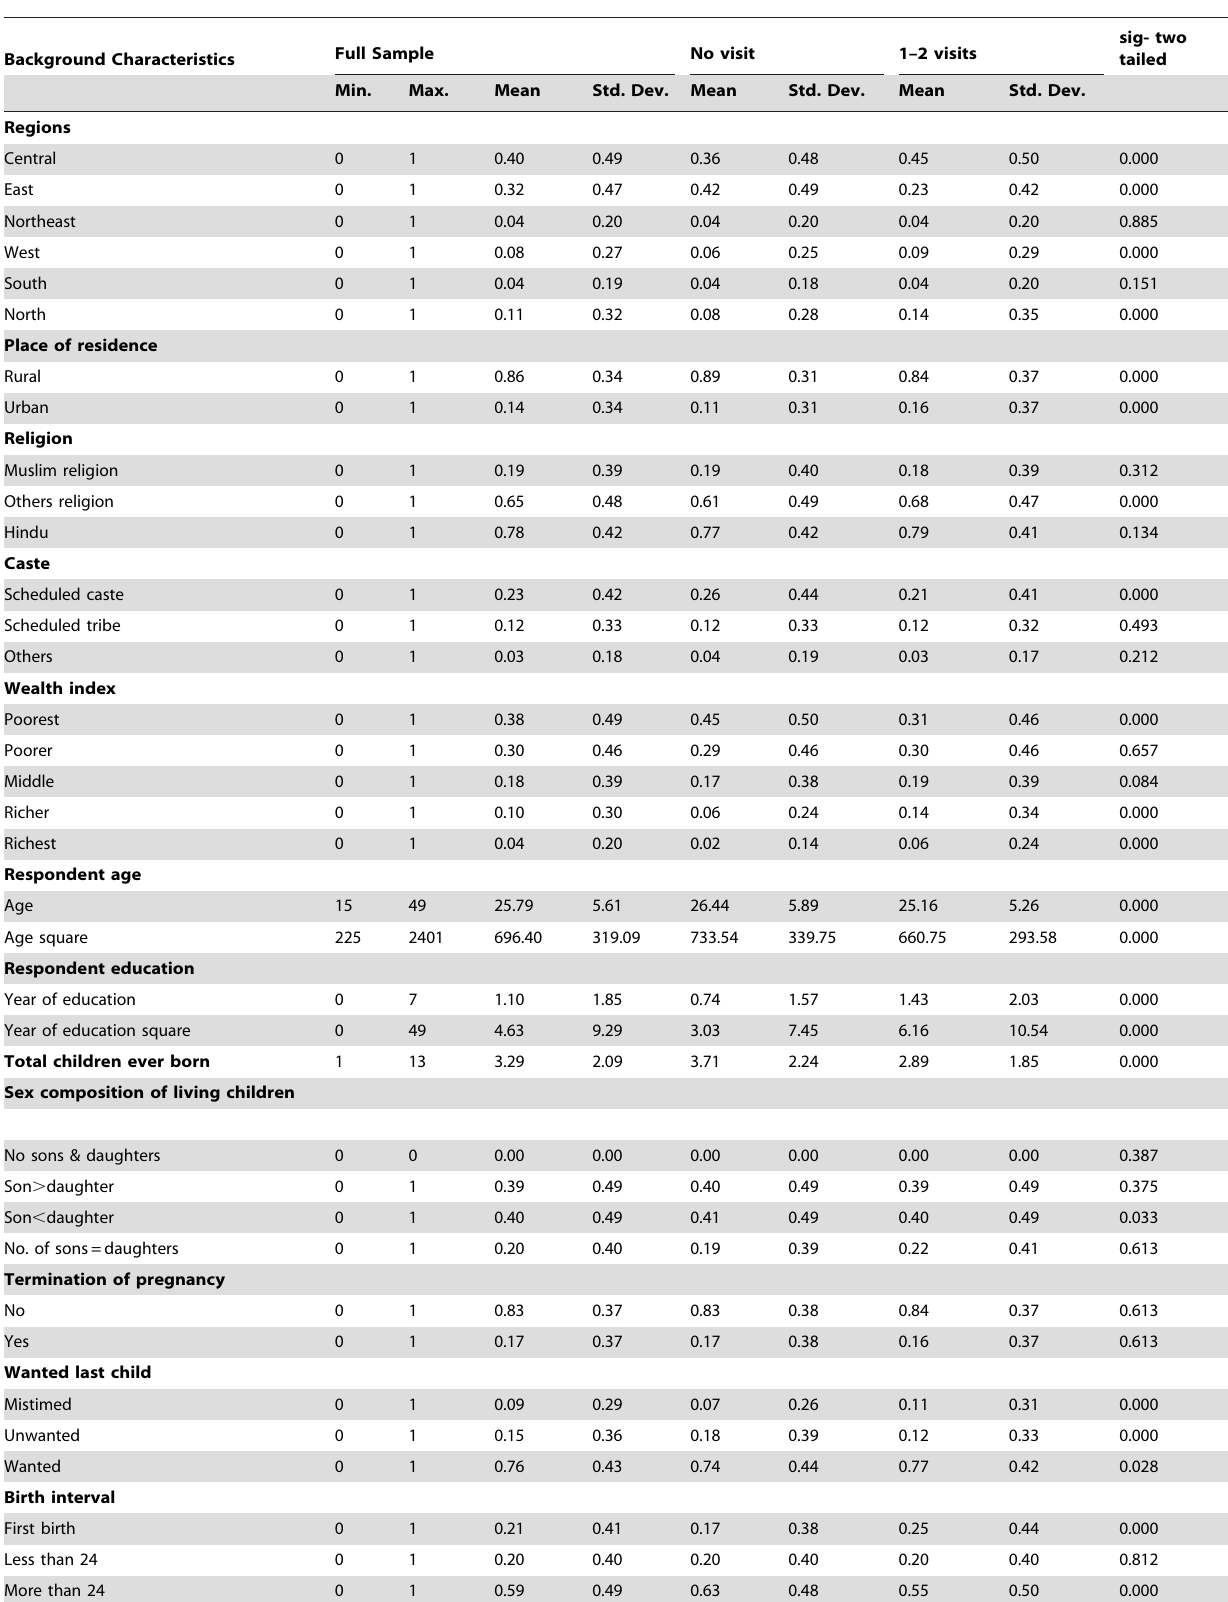
Table 1. Descriptive statistics by frequency of antenatal care visits, India, NFHS-2005–06.